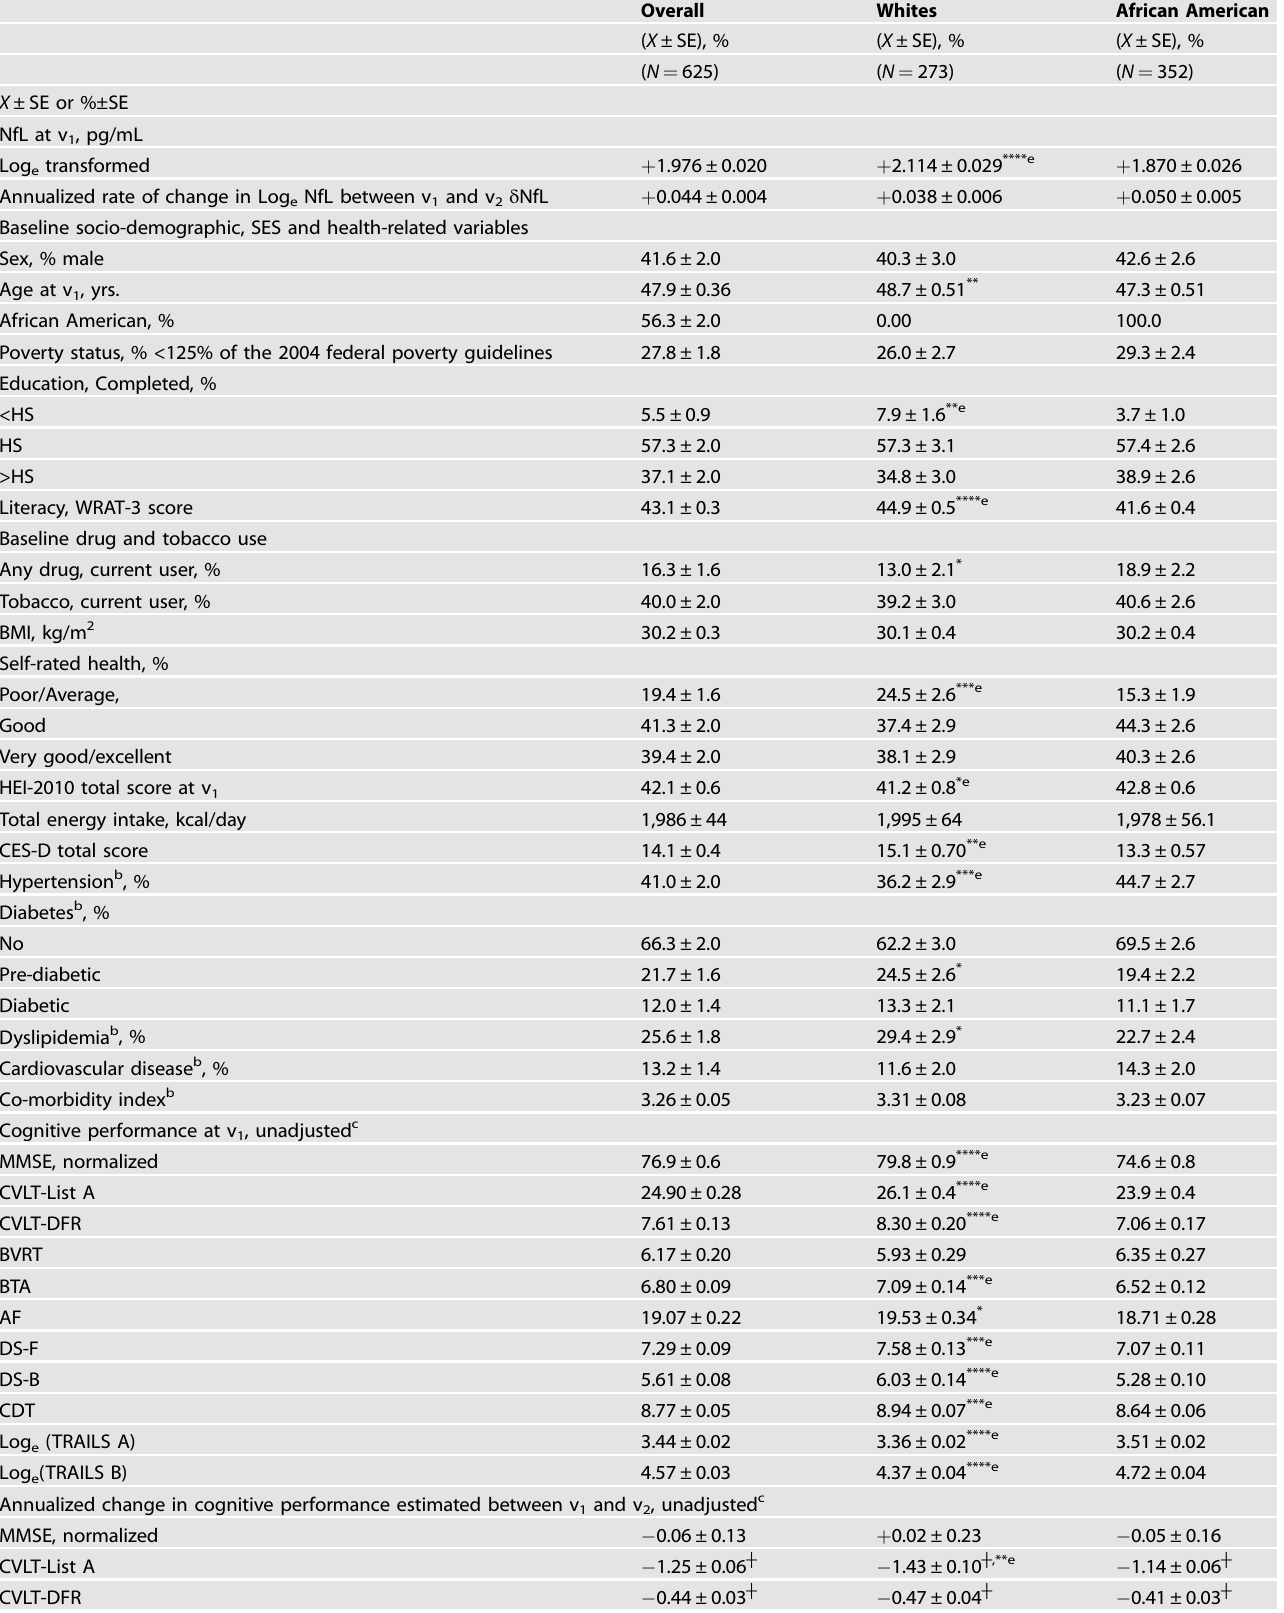
Table 1. Study sample characteristics, overall and by race in the fi nal analytic sample with imputed covariates ( N = 625), HANDLS 2004 – 2013 a . Overall Whites African